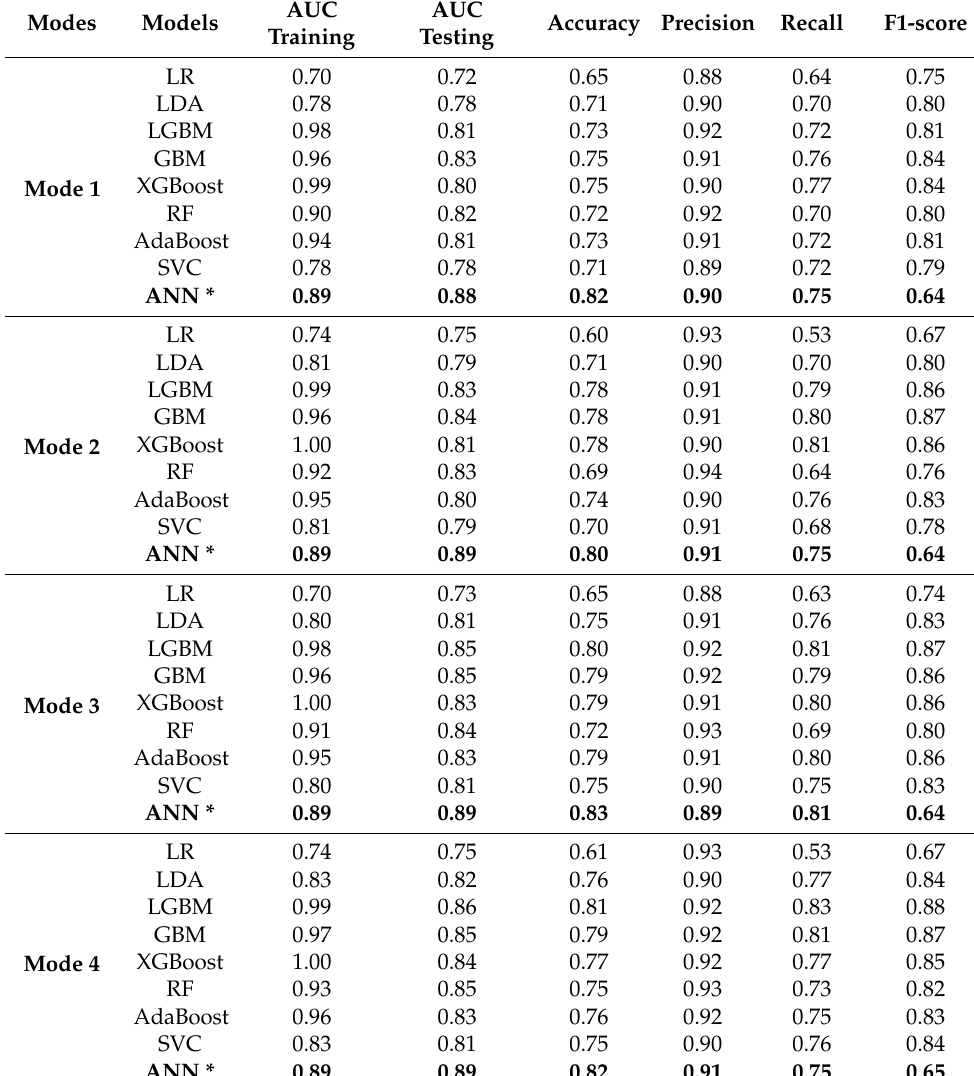
Table 2. Performance of various Prediction Models by